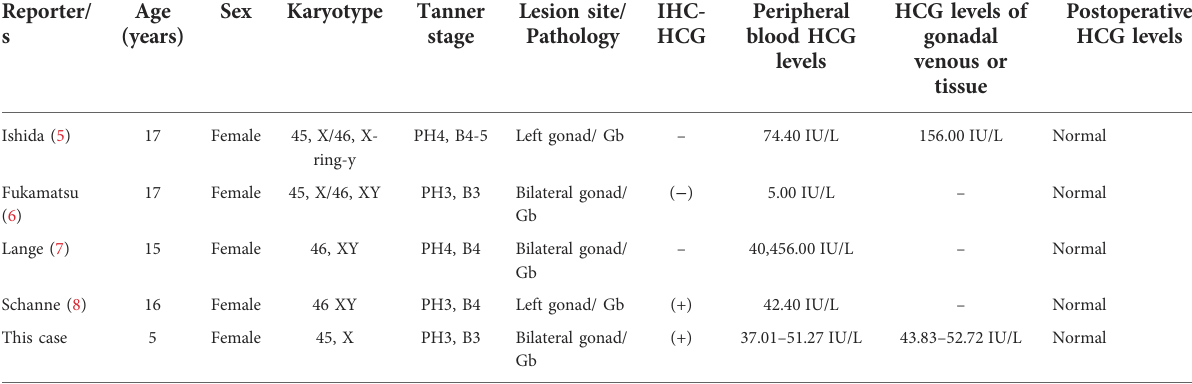
TABLE 4 Comparison of general data of 5 cases of Gb secreting HCG. Reporter/